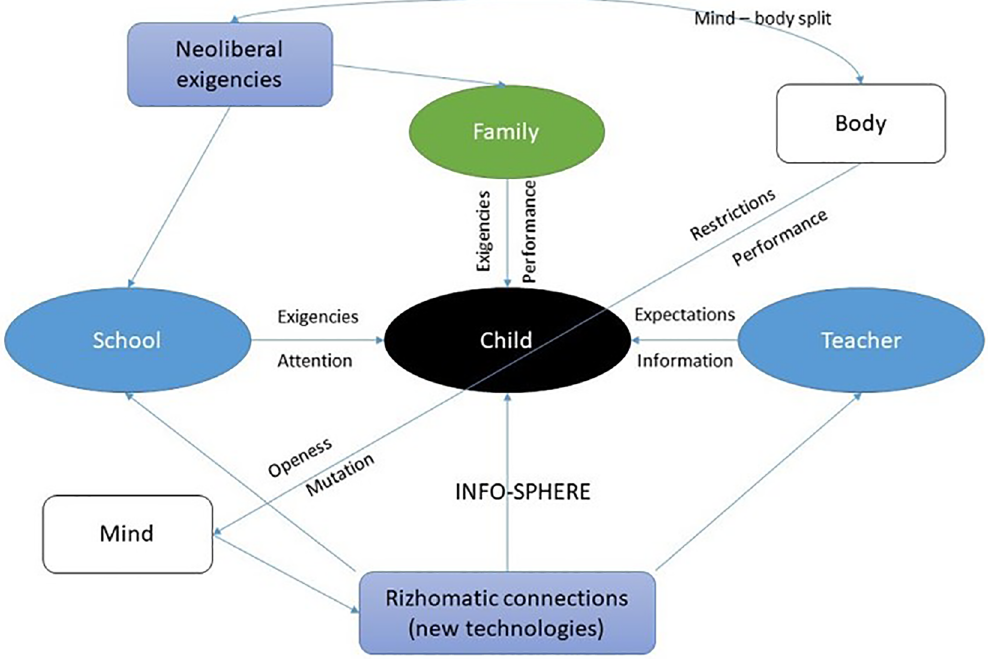
Figure 1. Building an ADHD